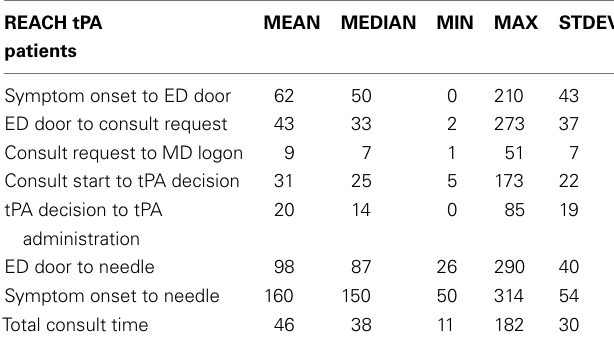
Table 3 | REACH operational times (in minutes) for patients